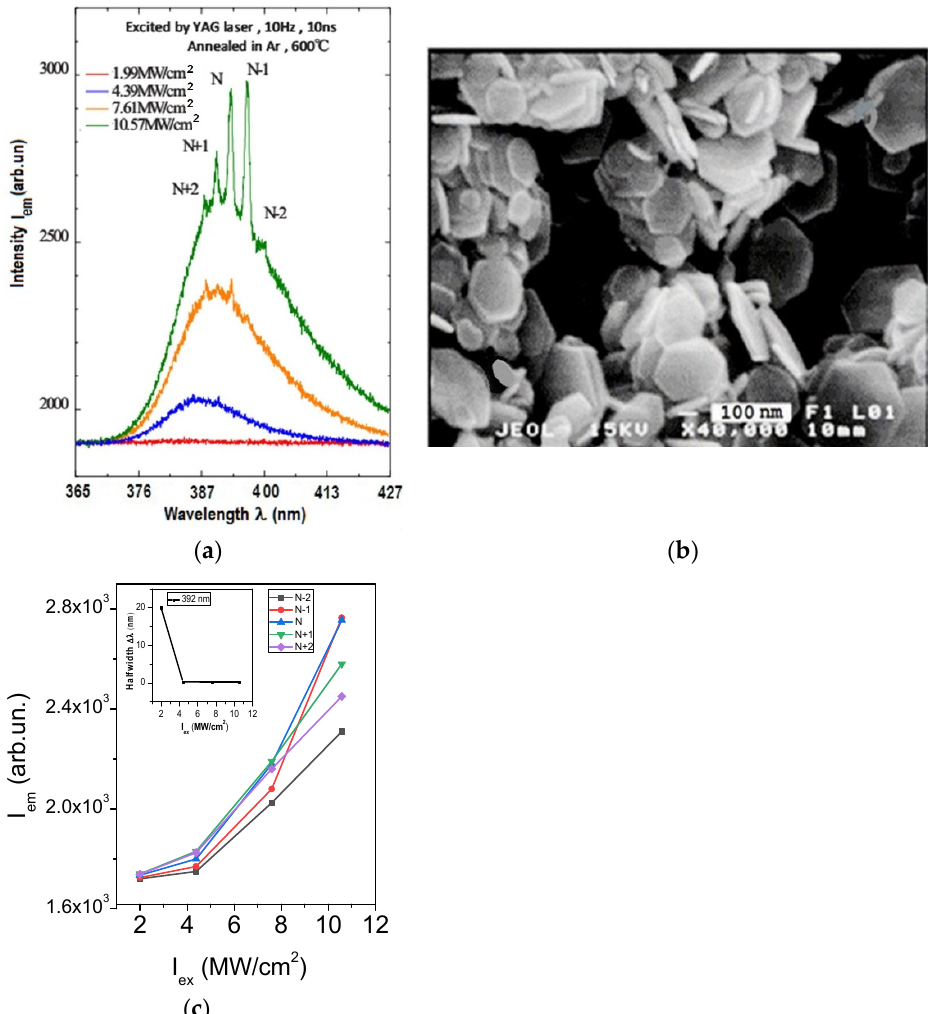
Figure 3. ( a ) Evolution of the PL spectr а in the compressed PNMC ZnO powder for different exci- tation intensities I ex ( λ ex = 337 nm) in the range of 0.12–2 (MW/cm 2 ) at room temperature. ( b ) De- pendences of the PL spectral bands intensity I pl versus the excitation intensity I ex ( λ ex = 337 nm) for different wavelengths, nm: 387, 405, 502. Insertion: band half-width Δ λ at 387 nm vs I ex . Hexagonal ZnO microdisks had a distribution with some disordered orientation in space and size variation Figure 4b [25]. In this case, the PL spectrum occurs with a comb- like regular arrangement of ultra-narrow bands (peaks) with halfwidth ∆ λ ~ 0.25 nm. Superlinear growth of I Pl in the range of excitation intensities I ex indicates the presence of coherent or “amplitude” FB [18]. Stimulated emission has a mode composition formed by whispering gallery modes (WGM) formed inside (on the faces) of hexagonal microdisks.